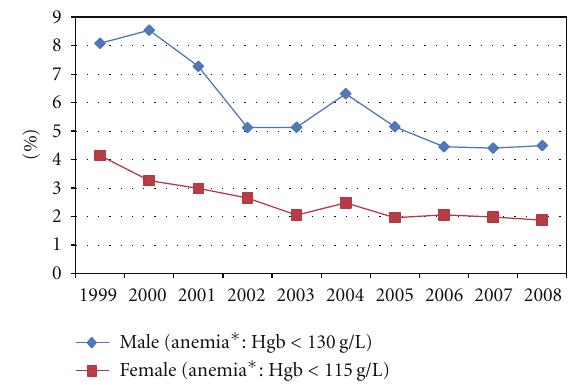
Figure 1: Prevalence of anemia in general population of patients. ∗ Anemia according to regional pathology is adult male with either “Hb < 130 g/L” or “hct < 36%”; adult females “Hb < 115g/L” or “hct <